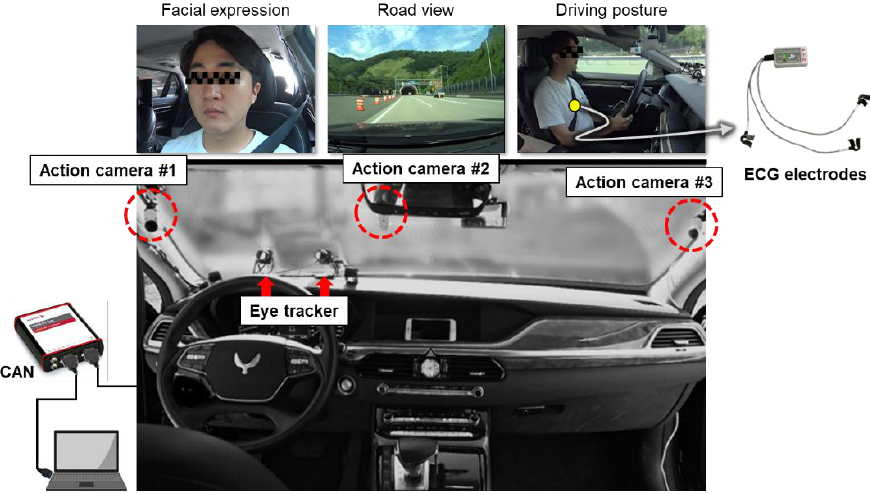
Figure 1. Driver cockpit for the on-road evaluation of passive task-related fatigue of the driver.